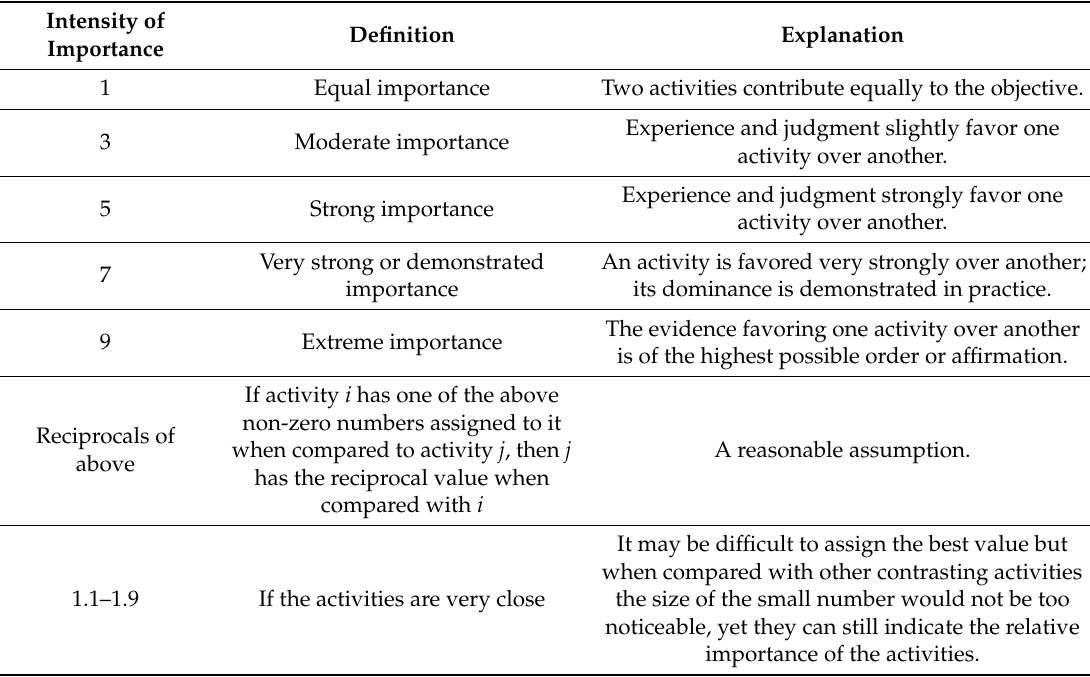
Table 2. The fundamental Scale of Absolute Numbers